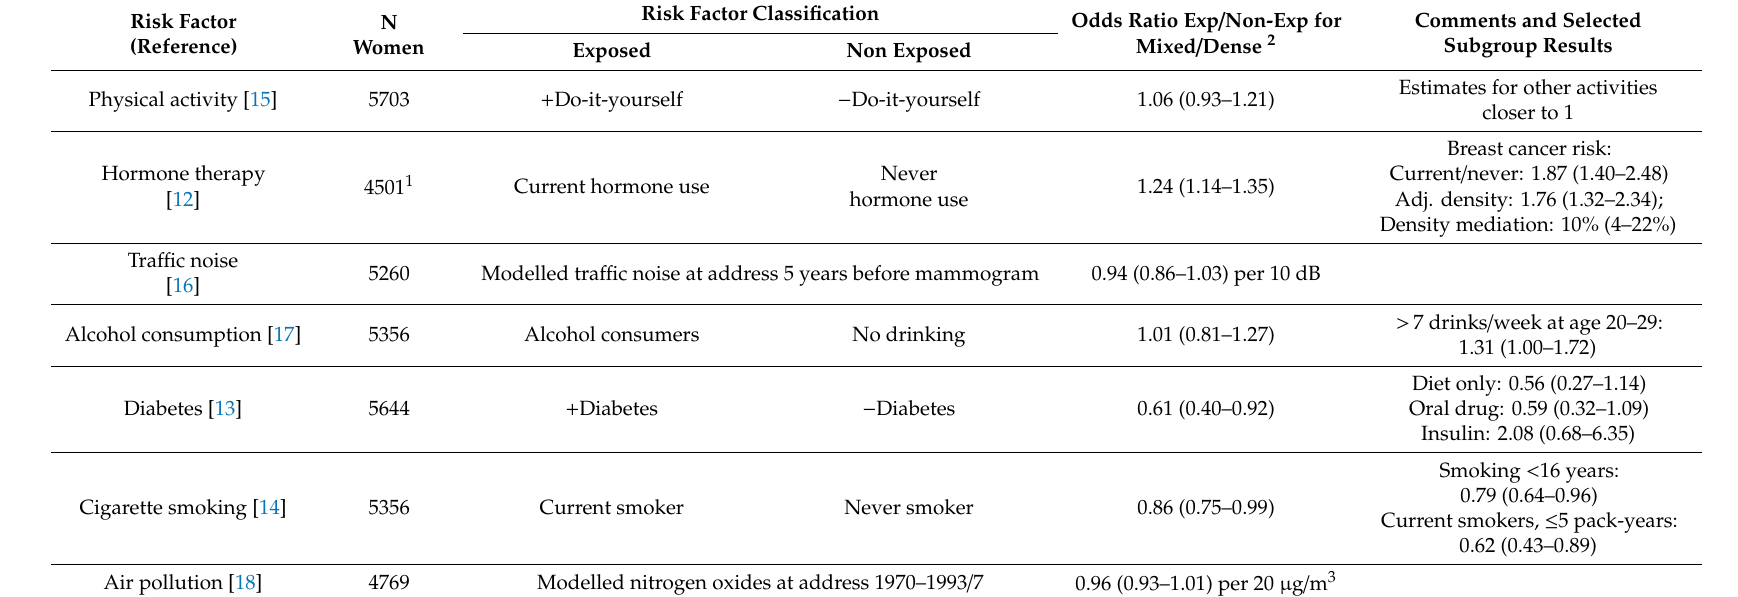
Table 2. Odds ratios between exposures recorded in the Danish Diet Cancer and Health study 1993–1997 and presence of mixed / dense breasts at first participation in the Copenhagen breast cancer screening program